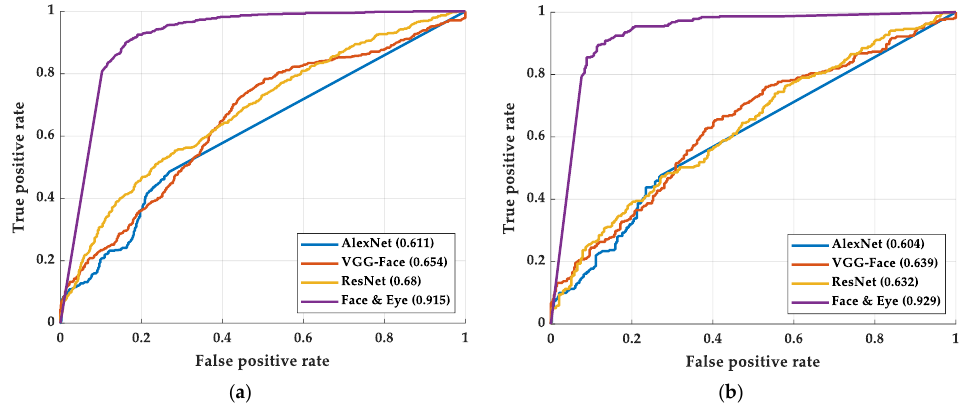
Figure 7. The AUC and ROC curve of the benchmark methods and our best method: ( a ) training process and ( b ) testing process.